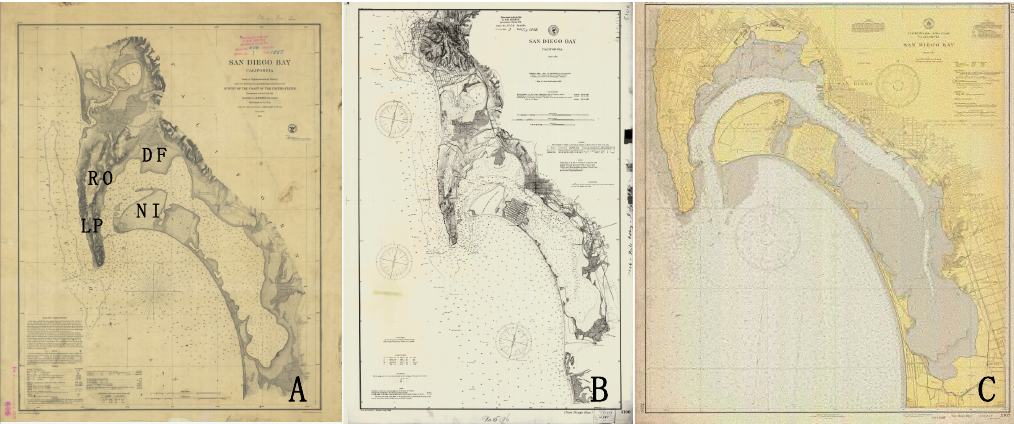
Figure 1. Maps of San Diego Bay. Depths are in feet. ( A ) Nautical chart of 1857. Approximate locations of Dutch Flat (DF), North Island (NI), Roseville (RO), and La Playa (LP) are shown in bold capitals; ( B ) Nautical chart of 1892. The major